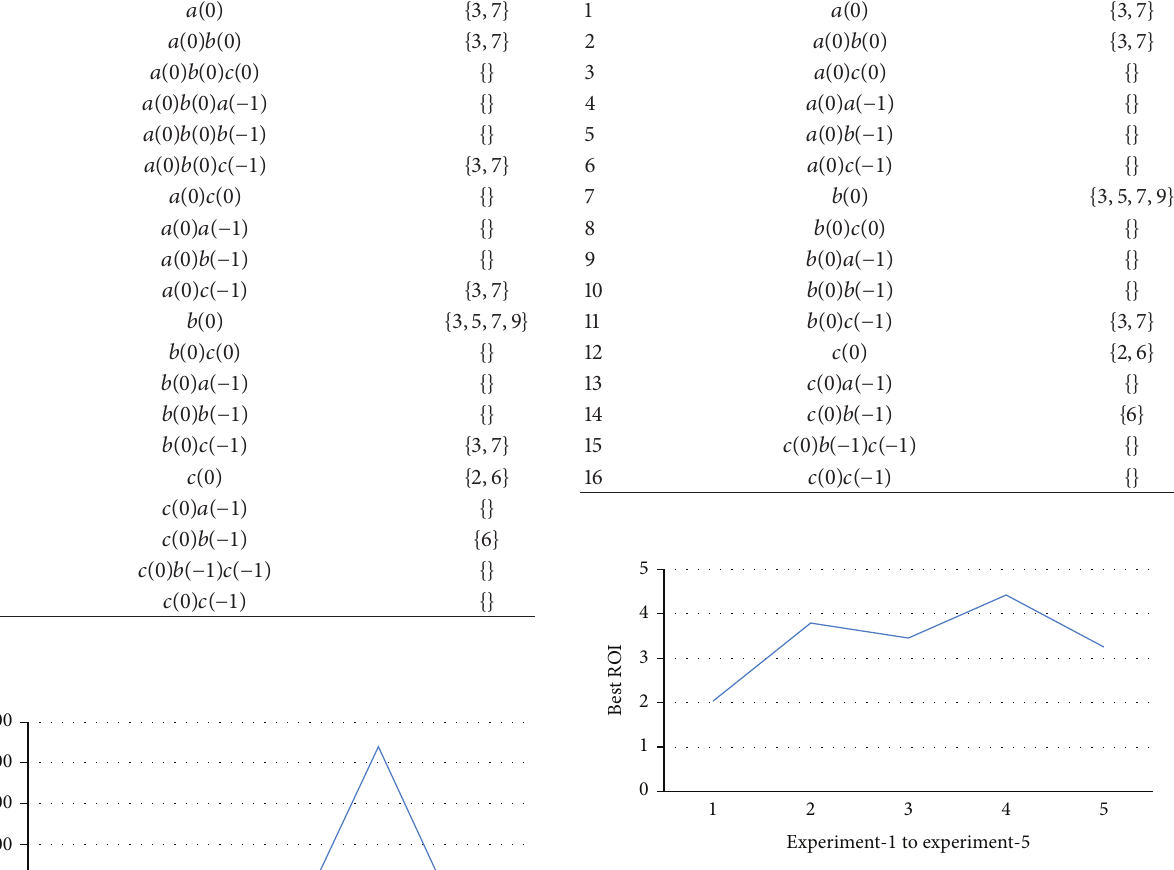
Table 10: The sequence of generated patterns using genBP. Seq.